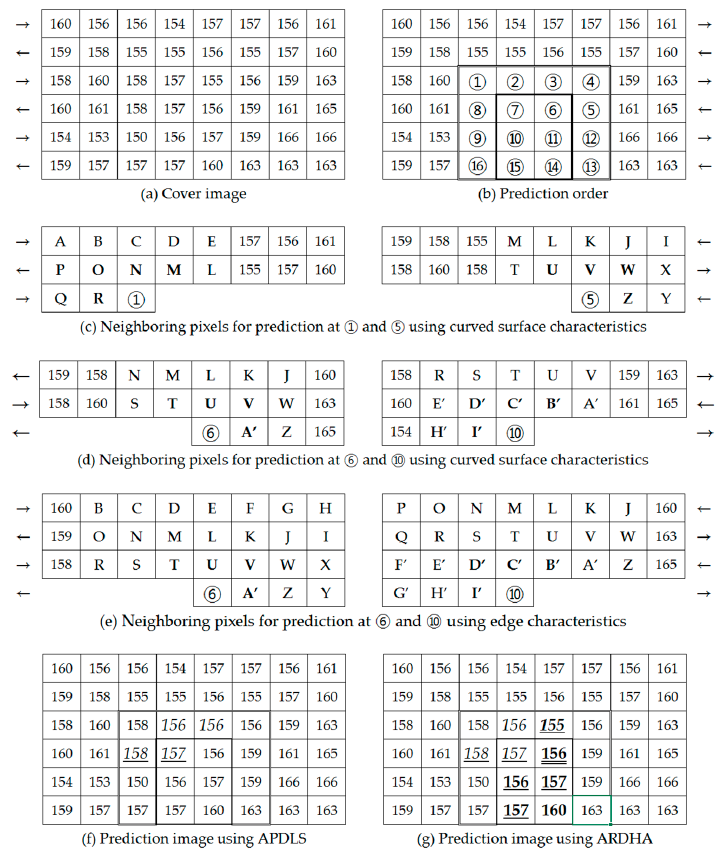
Figure 7. Sample cover image and prediction image.